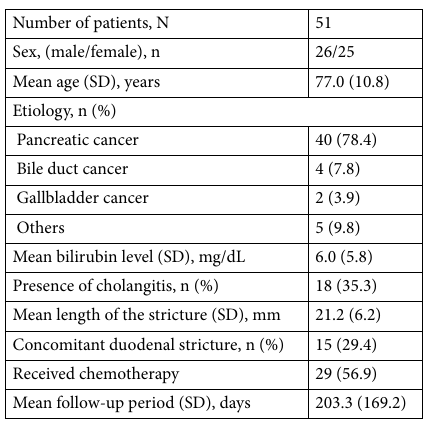
Table 1. Baseline characteristics of the participants. SD standard deviation.